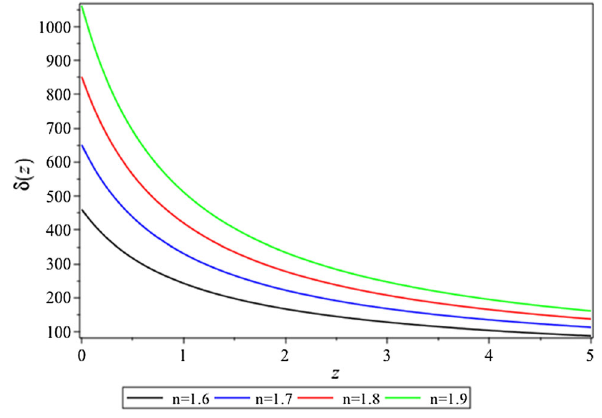
Fig. 4 The growth of the density contrast versus cosmological redshift forthepowerlaw f ( T ) gravitymodelforthefirstorderequations(133)– (138) for n > 1 . 5 and k = 10 5 and k =